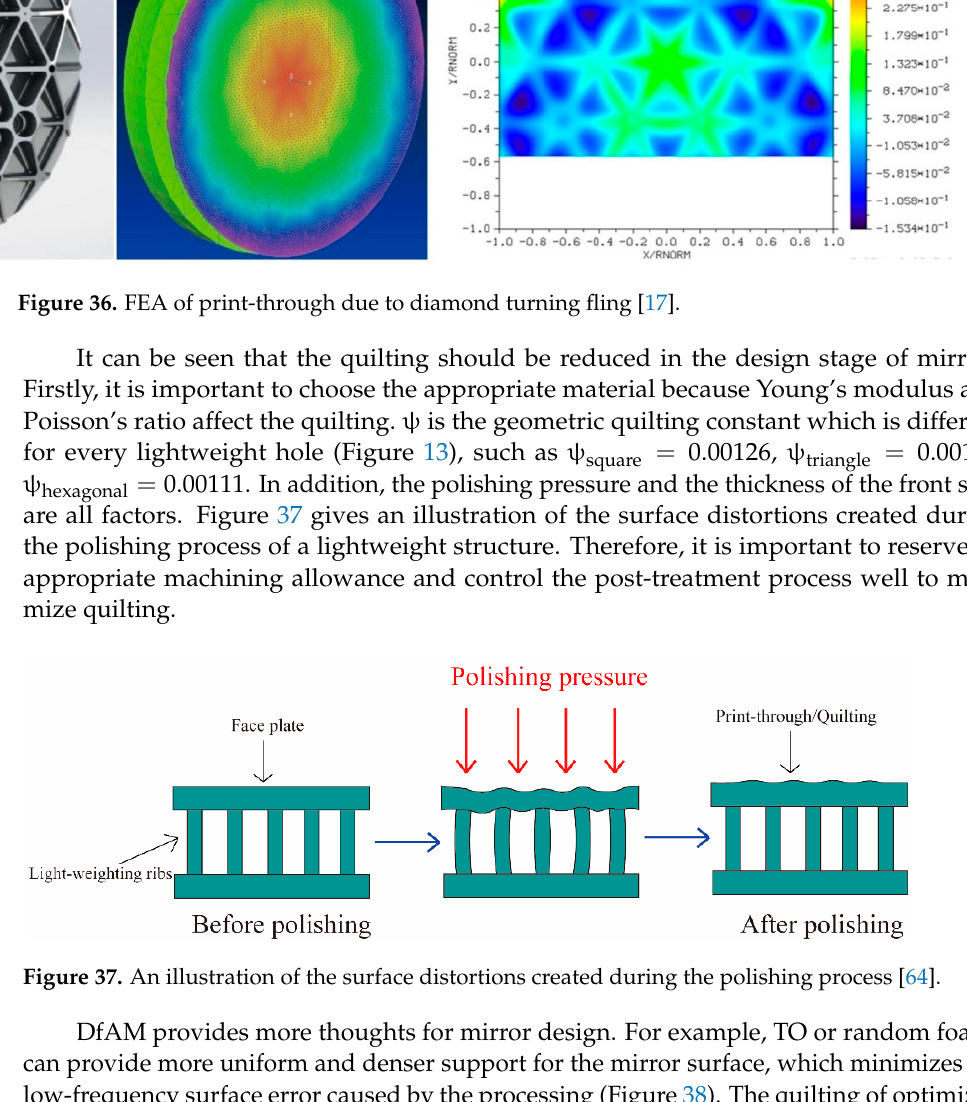
Figure 37. An illustration of the surface distortions created during the polishing process [64].